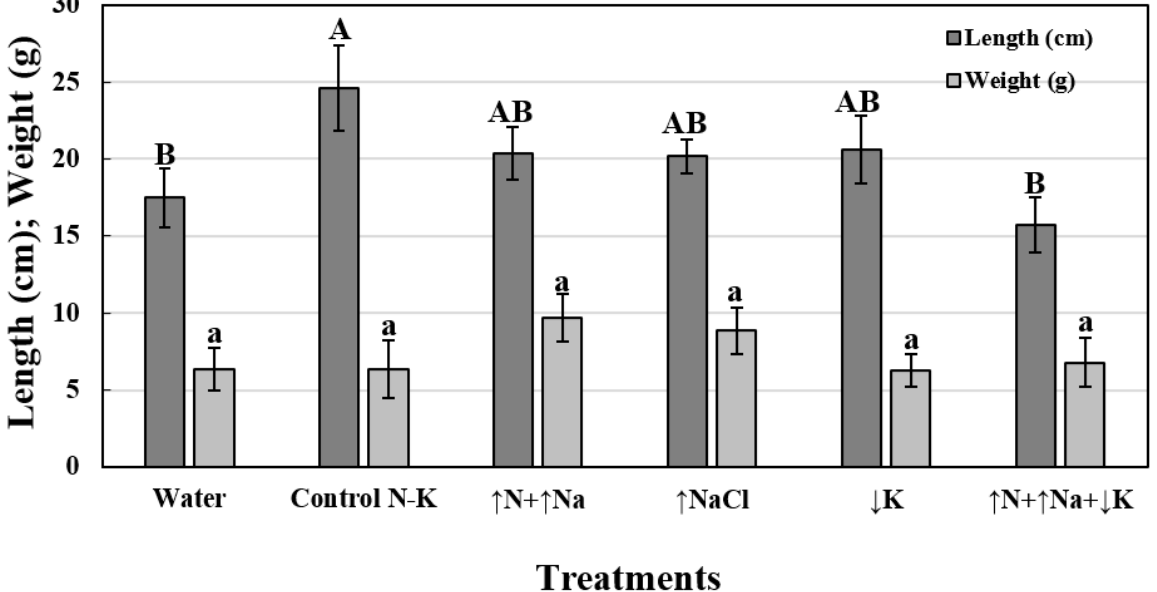
Figure 2. Effect of treatments on apical shoot development (length, cm; weight, g) in olive plants. For each dependent variable and treatment, columns represent the mean values of 24 plants, including both inoculated and non-inoculated plants, since no significant differences were found for the inoculation variable or its interaction with the treatments. Columns with the same uppercase or lowercase letter do not differ significantly according to Fisher’s protected LSD test ( P = 0.05) for ‘length’ and ‘weight’ variables, respectively. Vertical bars represent the standard errors of the mean. Finally, V. dahliae was consistently re-isolated from the stems of inoculated plants, with frequencies of isolation ranging from 57.1% to 85.7%. However, the pathogen was not re-isolated from non-inoculated plants. This fact confirmed that plants used for the experiment were initially healthy and indicated the success of the